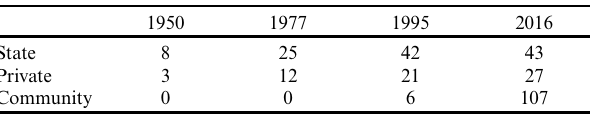
Table 3 . Number of operational conservation areas